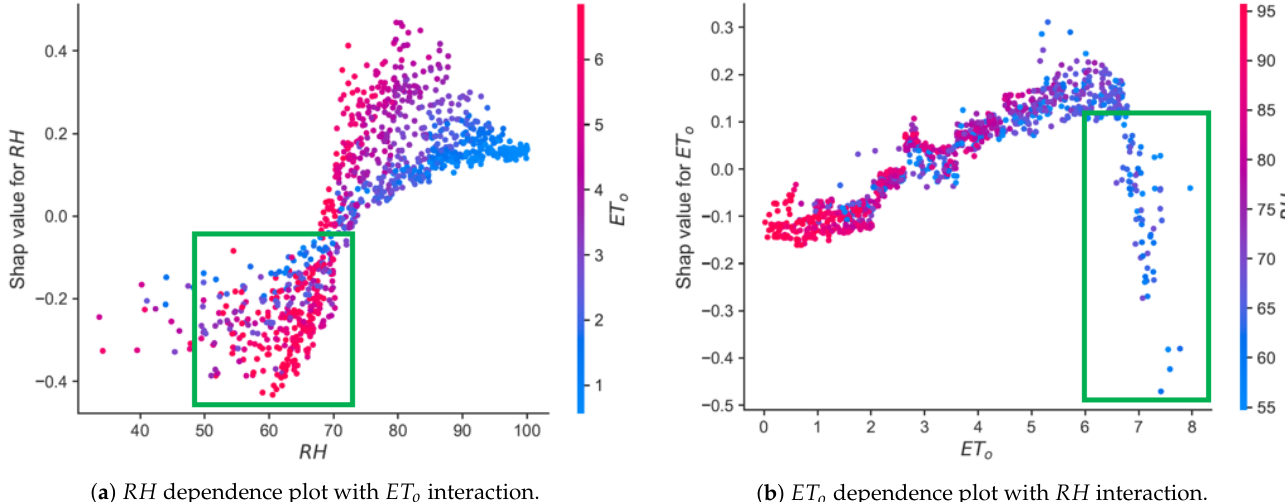
Figure 6. Dependence & interaction plots revealing the interrelationship between RH , ET 0 , and the corresponding Shap values. The Shap values represent the model’s behavior to either push the ET a value higher or lower. A higher Shap value means that the model is trying to produce a higher ET a prediction, and vice-versa. The green boxes highlight the regions where low RH values correspond to high ET o values but low ET a predictions, which could be attributed to soil moisture